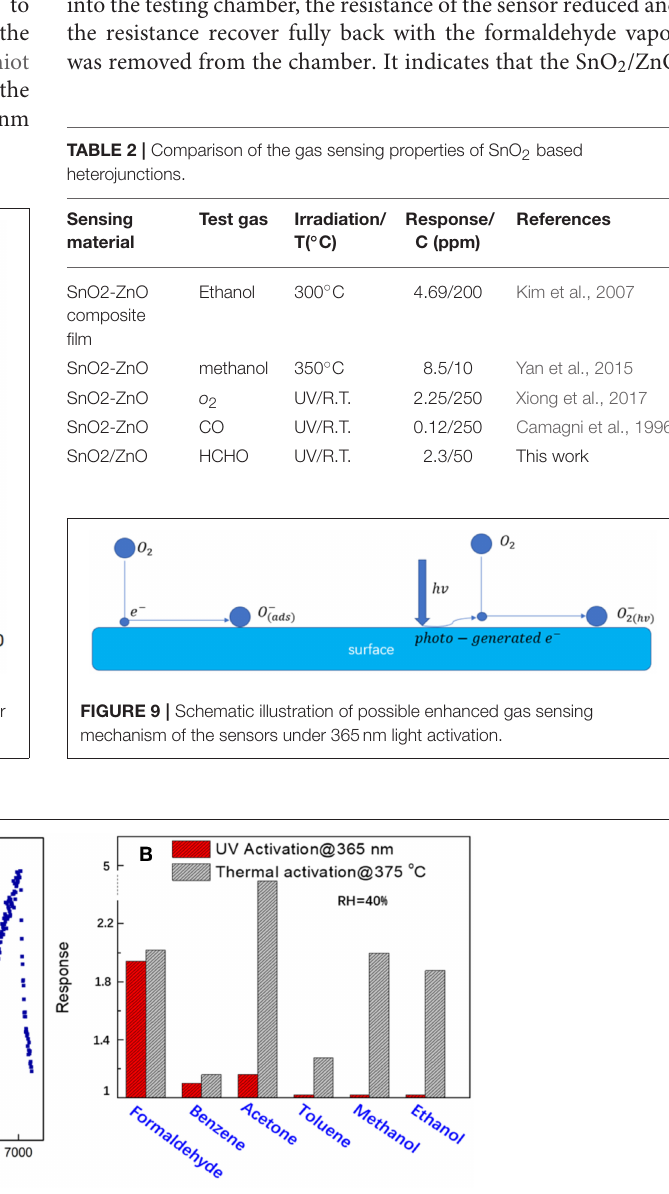
Frontiers in Materials |